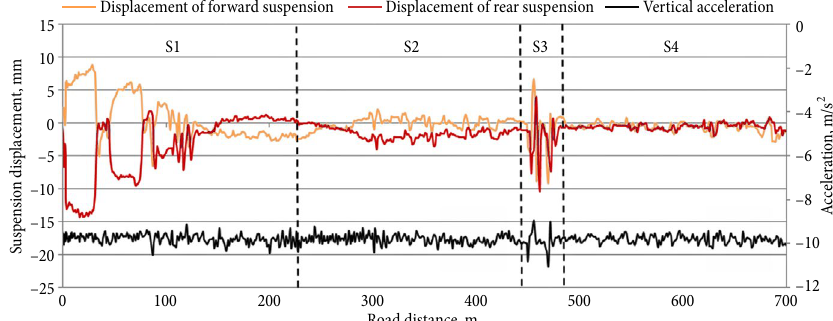
Fig. 4. The road roughness (height of road irregularities) of the selected road section